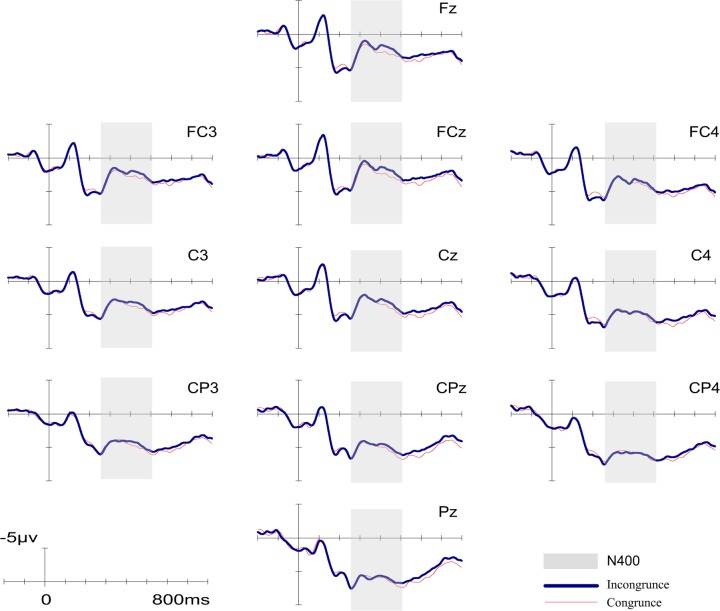
Grand-averaged ERPs in the Experiment 1 (music major group).N400 time windows are highlighted with gray markers. ERPs of related condition is shown as red thin lines and unrelated condition is shown as blue thick lines.